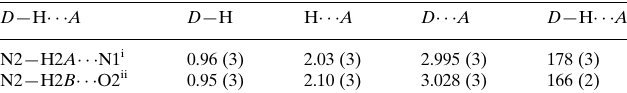
Hydrogen-bond geometry (A˚ , (cid:2)